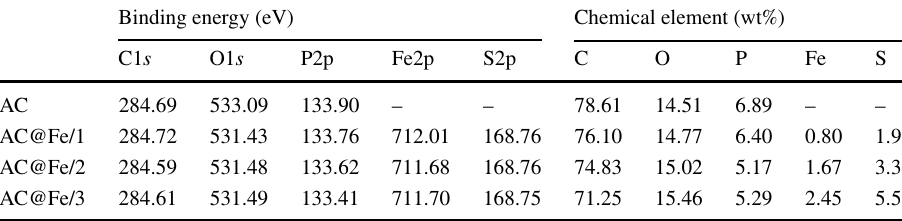
Binding energy (eV)